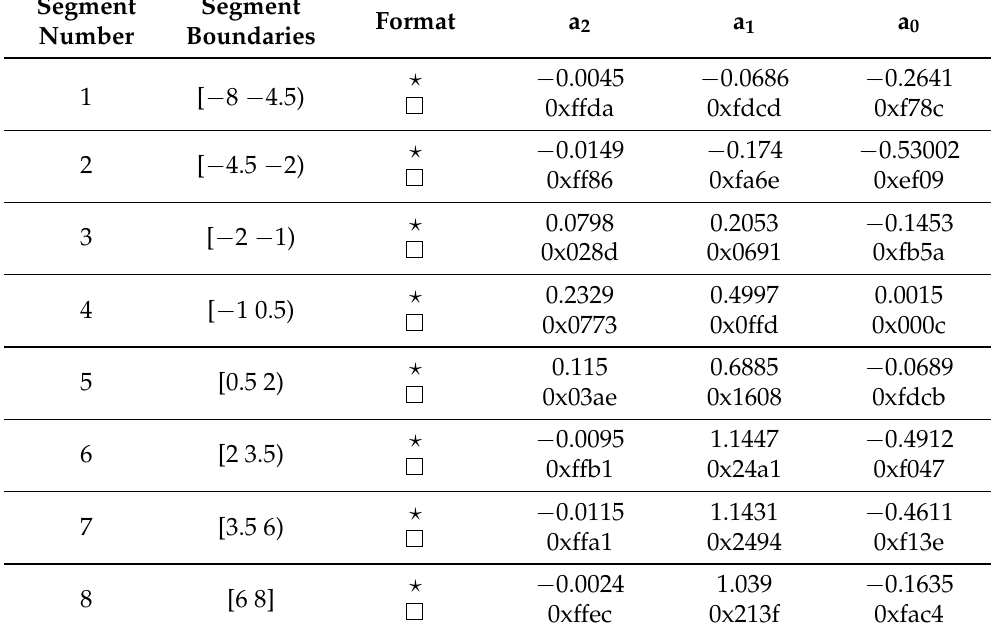
Table 6. Floating-point and fixed-point coefficients for implementing SILU AF in